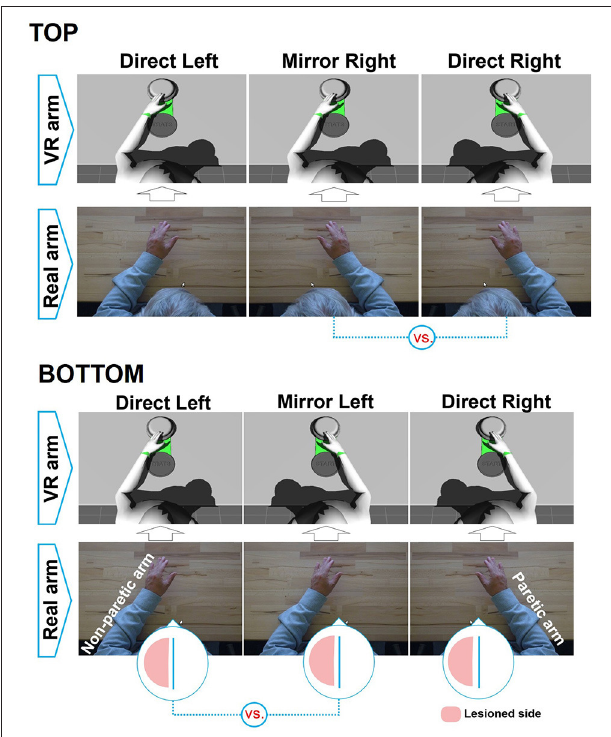
FIGURE 2 | Illustrated feedback conditions (top) for healthy participants and (bottom) for the stroke participant. The comparisons made to investigate MVF are shown